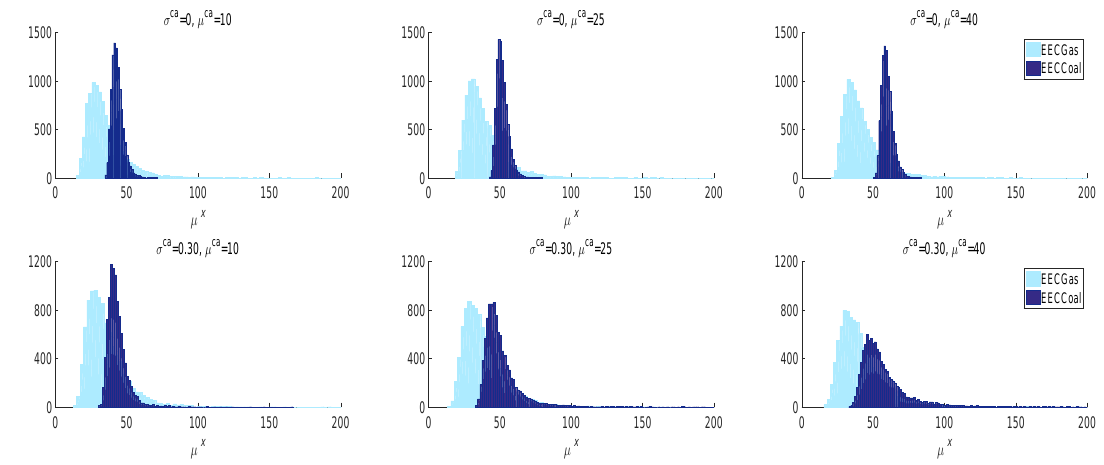
Figure 1. Electricity Economic Cost (EEC) distributions in the two carbon volatility scenarios σ ca = 0, 30% (top, bottom) for µ ca = 10, 25, 40 (from left to right).